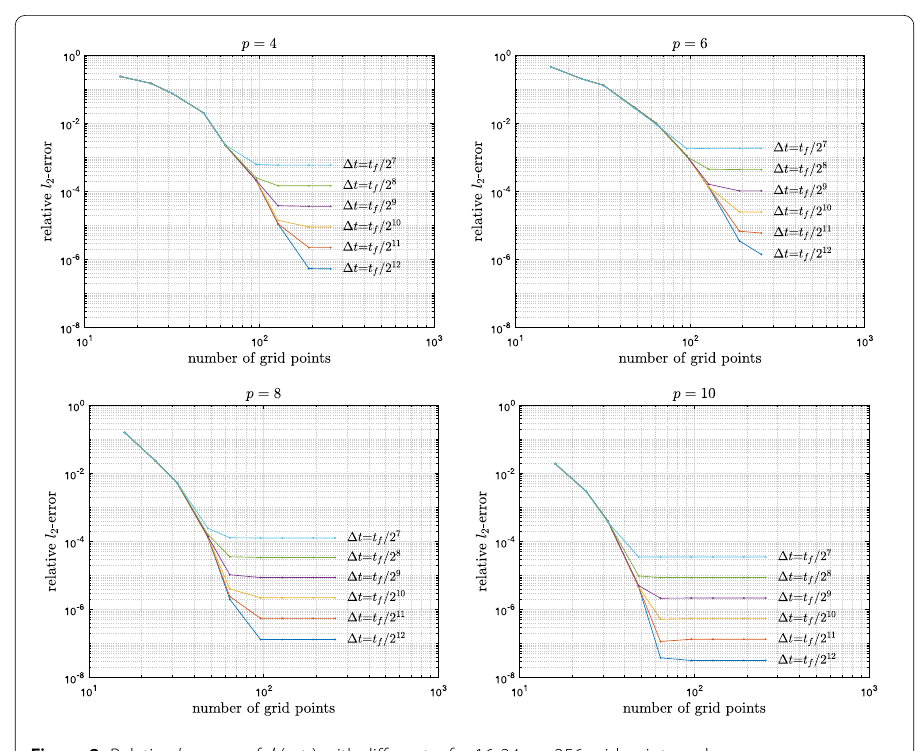
Figure 2 Relative l 2 -errors of φ ( x , t f ) with different p for 16,24, ... ,256 grid points and (cid:7) t = t